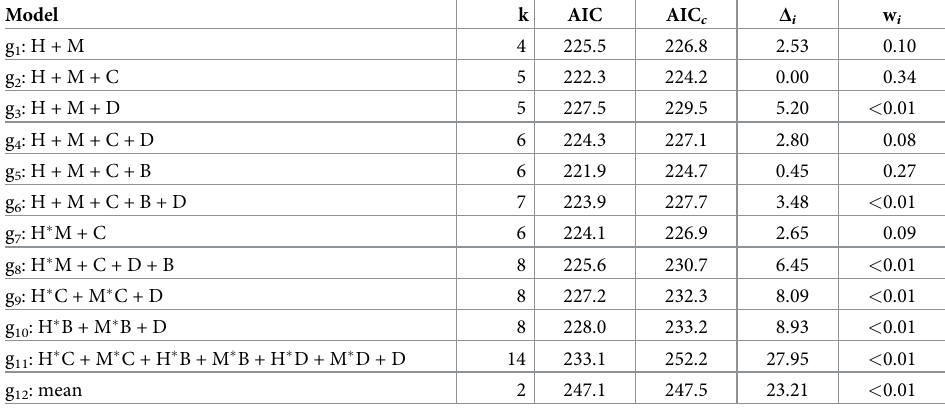
Table 3. Information theoretic analysis [71] of 12 GLM models (g i ) using habitat type (H), month (M), water depth (D), plant % cover (C) and plant biomass (B) as predictors of juvenile blue crab density, where k is the num- ber of parameters in a model, AIC is the Akaike information criterion, AIC ence between any model and the best model in the set, and w i is the model probability. Model g 9 is the global model and model g 10 is the null